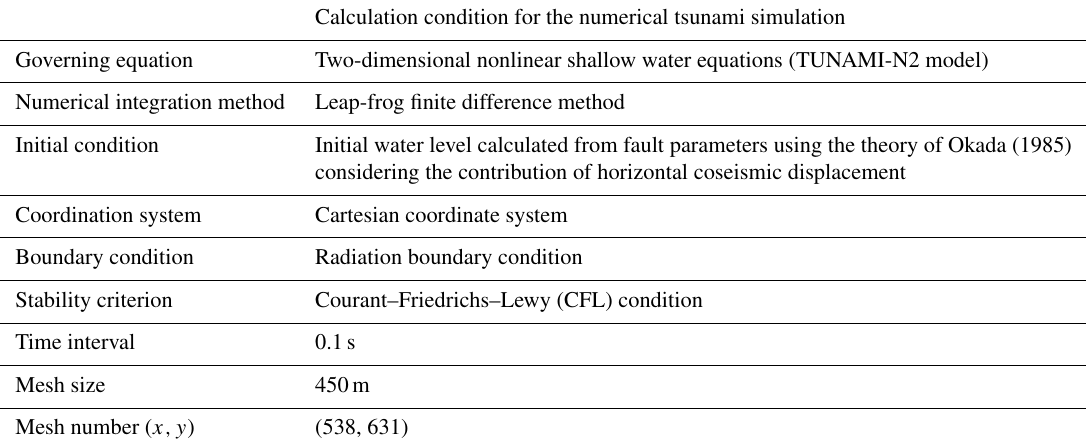
Table 1. Calculation conditions for the numerical tsunami simulation.